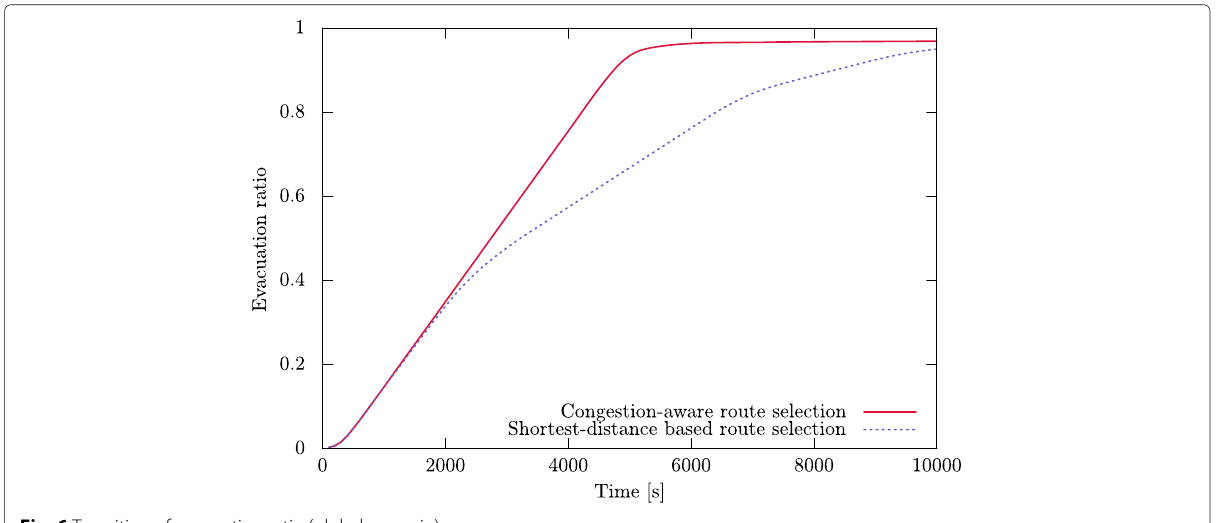
Fig. 6 Transition of evacuation ratio (global